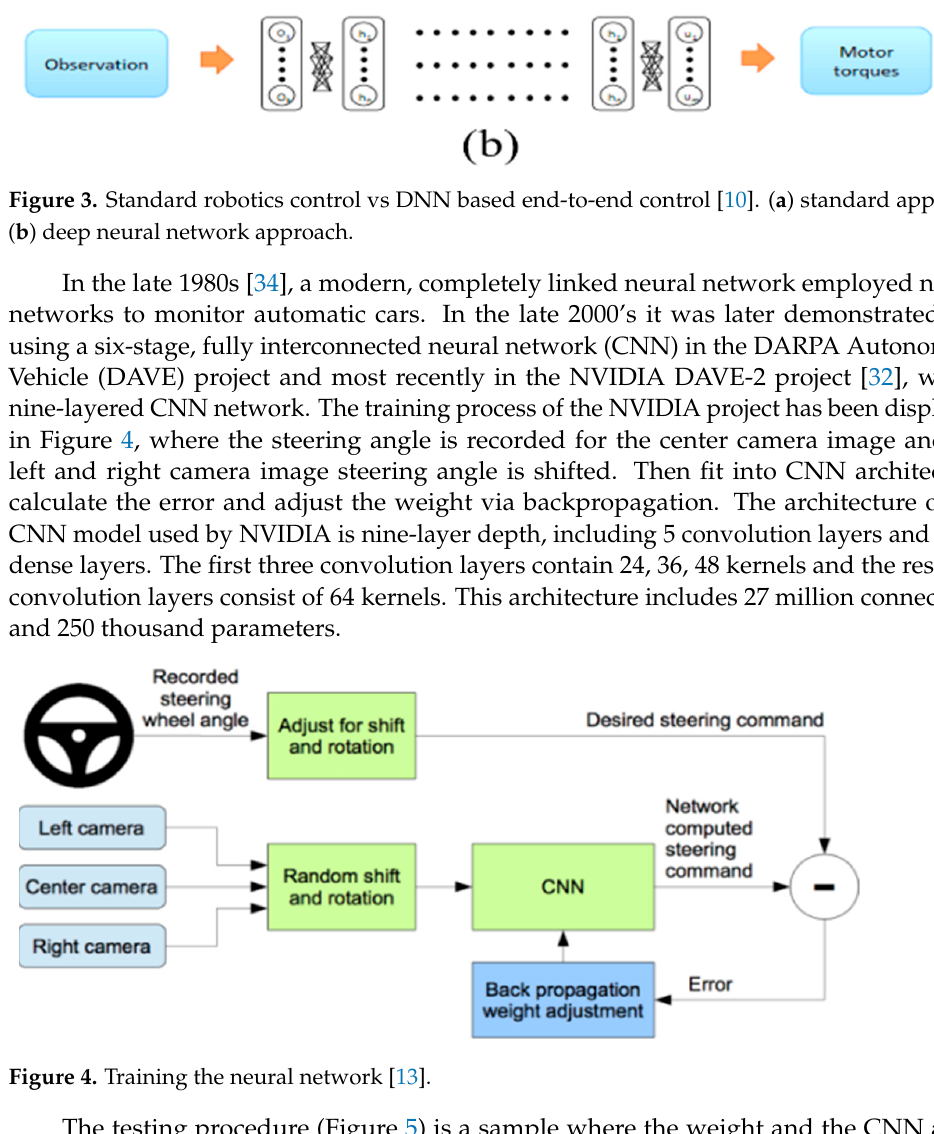
Figure 3. Standard robotics control vs DNN based end-to-end control [10]. ( a ) standard approach ( b ) deep neural network approach.